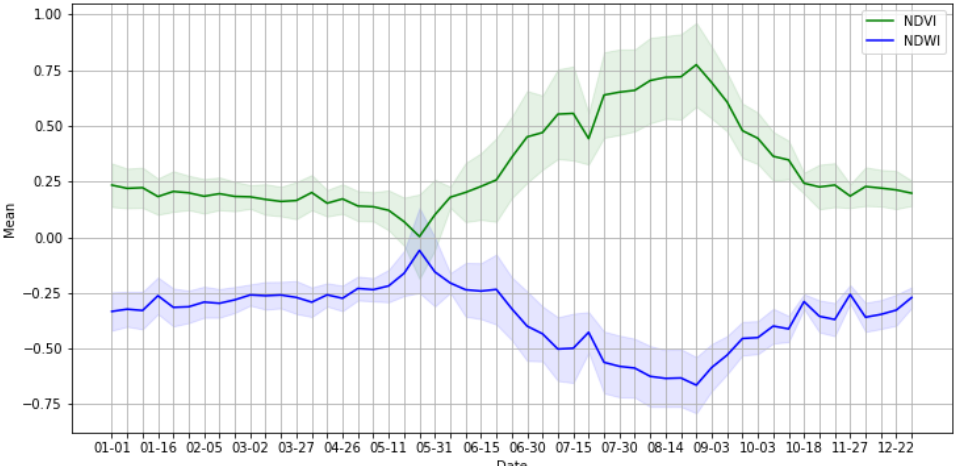
Figure 7. The phenological curve for the 2019 season in the study area, based on the mean and twice the standard